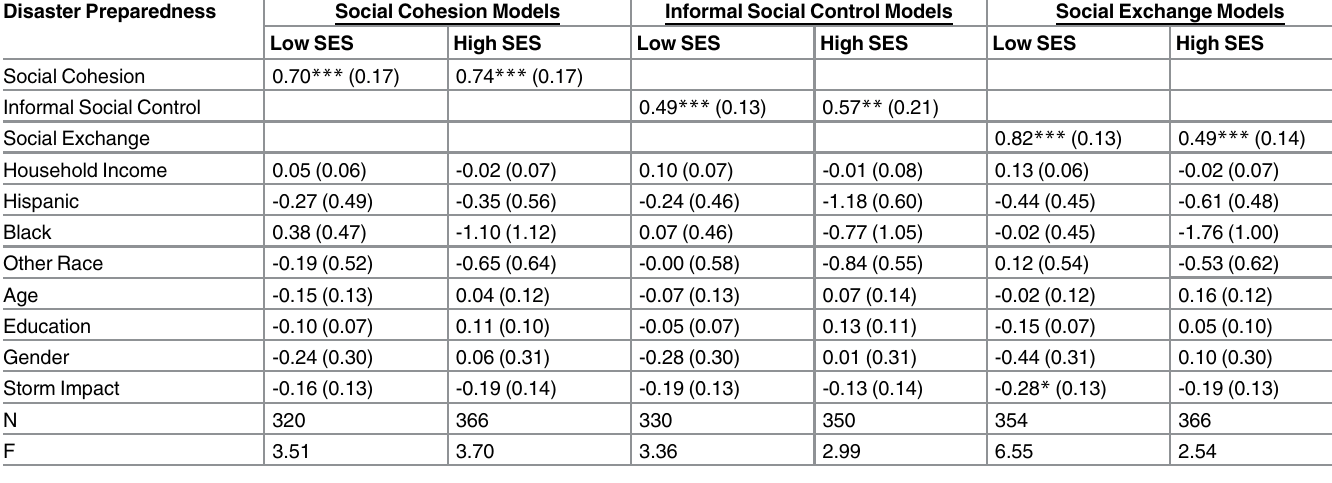
Table 4. Social resources and their associations with beliefs about disaster preparedness for low and high SES neighborhoods.